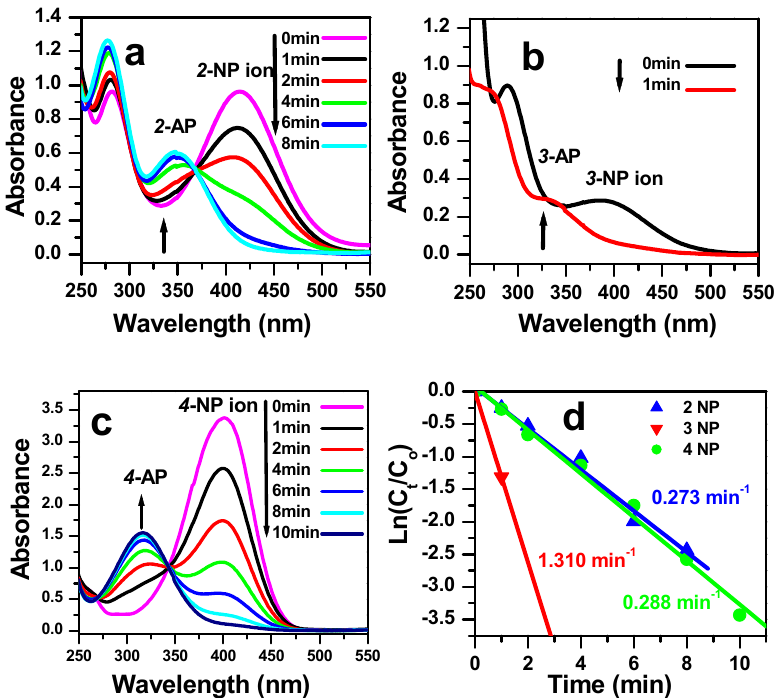
Figure 7. Successive UV-vis spectra of the reduction of ( a ) 2-nitrophenol solution (4 × 10 − 4 M); ( b ) 3-nitrophenol solution (4 × 10 − 4 M); ( c ) 4-nitrophenol solution (4 × 10 − 4 M) in the presence of 8 × 10 − 4 M NaBH 4 using β -CoMoO 4 nanocatalyst (0.1 g); ( d ) Plot of ln(C/C 0 ) against reaction time for the nitrophenol isomers in the presence of β -CoMoO 4 and determination of the reduction reaction rate constant k app .